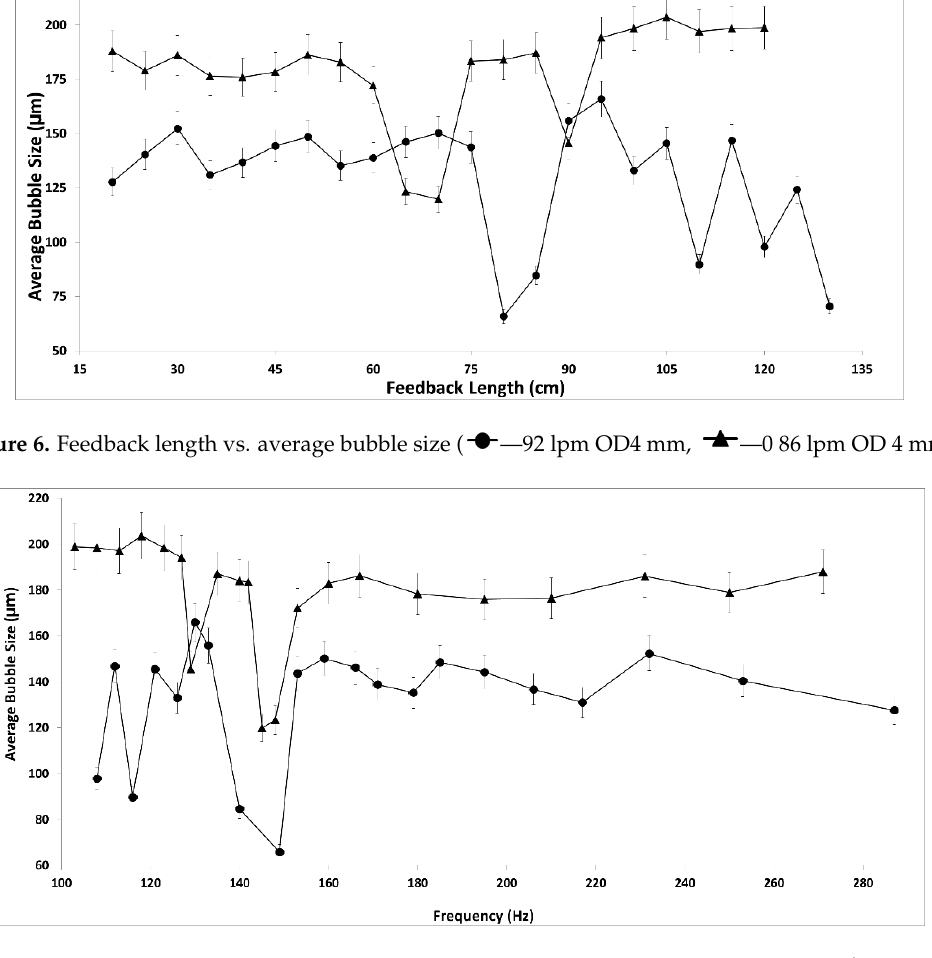
Figure 7. Frequency vs. average bubble size at different flow rates ( —92 lpm OD4 mm, —86 lpm OD 4 mm).